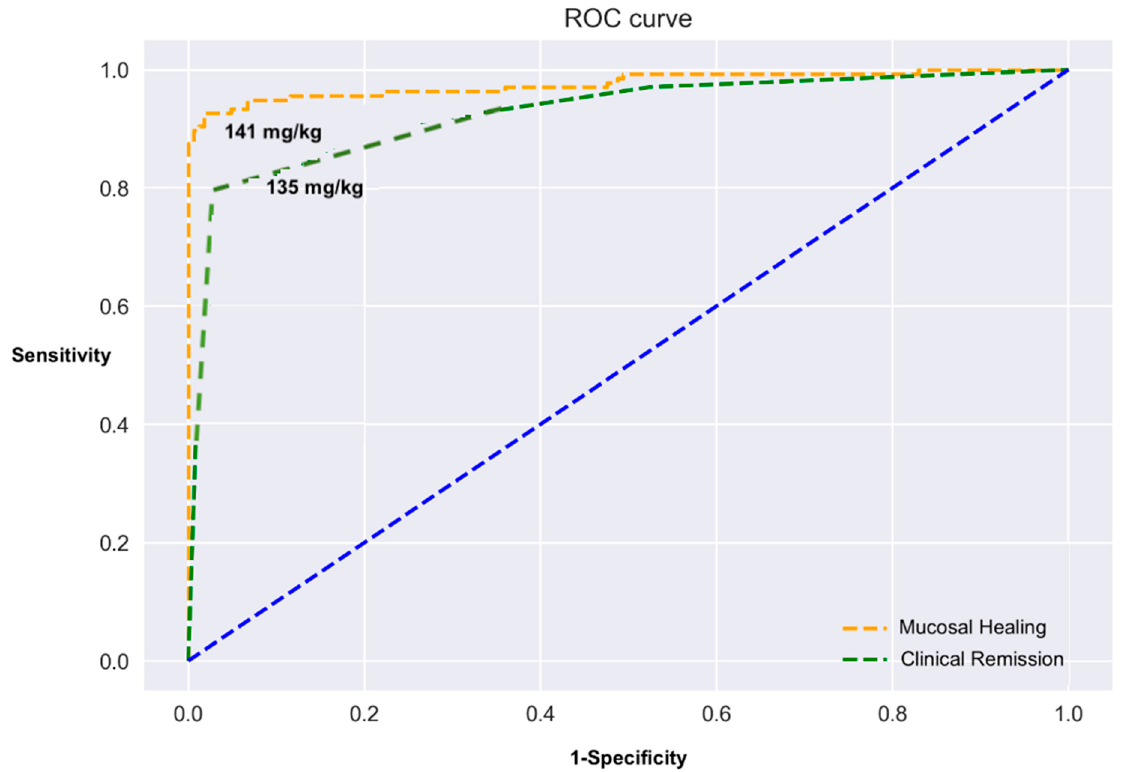
Figure 3. Receiver operating characteristics (ROC) curve assessing the predictive performance of absolute fecal calprotectin levels after induction for mucosal healing and clinical remission.